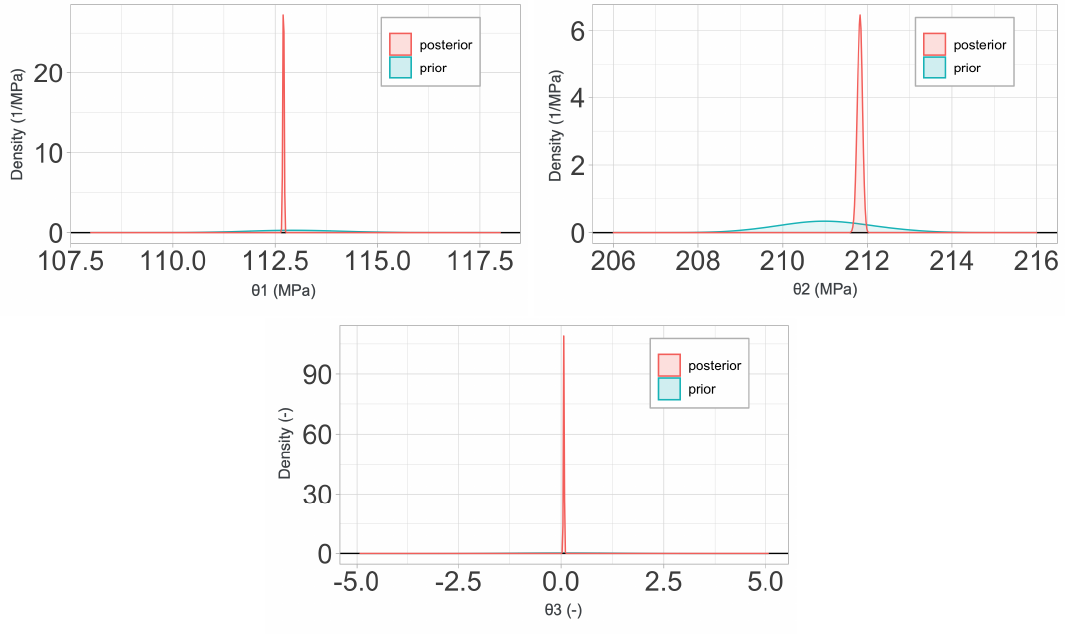
Figure 13. Prior vs. posterior probability distribution functions of parameters A ∼ θ 1 , B ∼ θ 2 , C ∼ θ 3 , in the JC model considering ∆ R as the